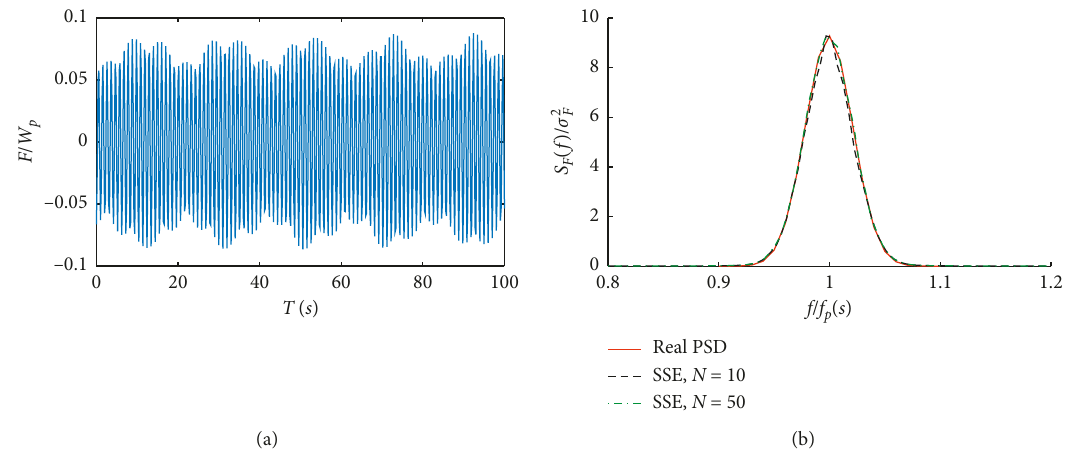
Figure 1: Simulation of ξ ( t ) by using the SSE method: (a) one discrete sample generated by SSE; (b) PSDs under different discrete harmonic components and the comparison with real